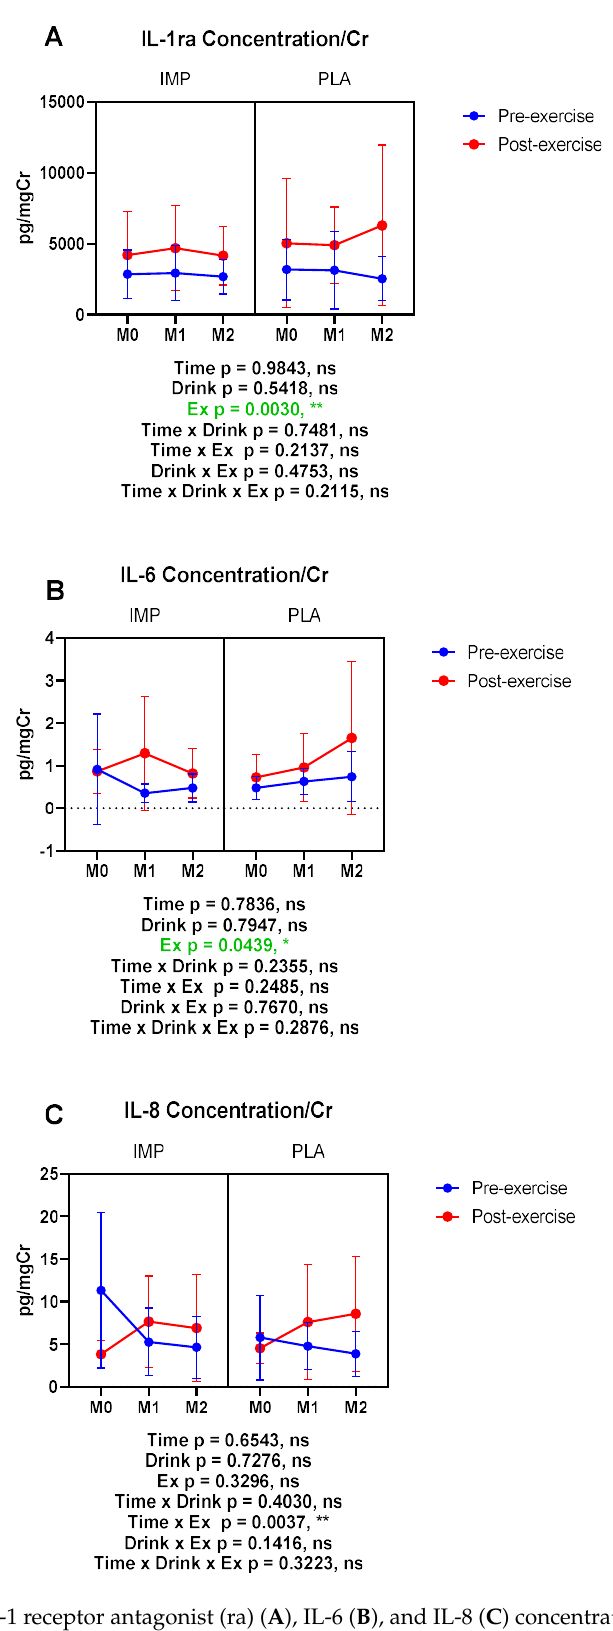
Figure 10. Urine IL-1 receptor antagonist (ra) ( A ), IL-6 ( B ), and IL-8 ( C ) concentrations corrected with creatinine. The data are presented as means ± SD. * p < 0.05 and ** p < 0.01. Green text indicates a significance < 0.05.